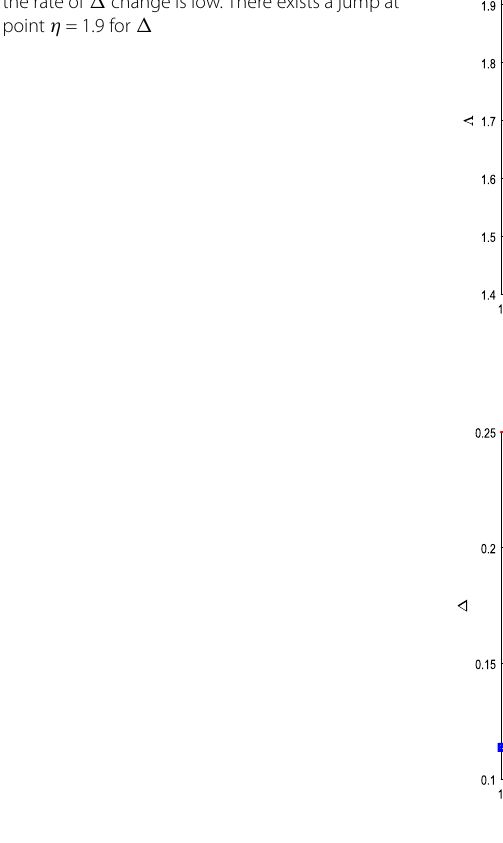
Figure 4 Graphical representation of (cid:25) and (cid:27) for η ∈ J = [1,2] and ρ = 1 , σ = 1 , where ψ 4 ( z ) = 2 z , in 2 2 Example 5.1. In this case, ψ is a power function and the rate of (cid:27) change is low. There exists a jump at point η = 1.9 for